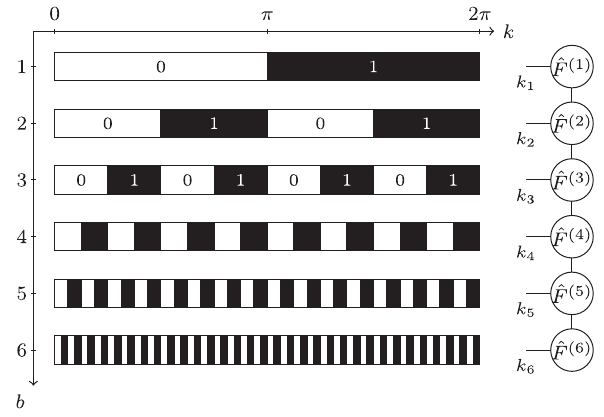
1. Multiscale ansatz for momentum space. Each row, numbered by the bond index b , corresponds to a different level of discretization of the 1D momentum k (different length scale). In this way, k can be represented by a set of bits k 1 ; … ; k (see text). R On the right, the QTT representation of a momentum-dependent FIG. 2. (a) QTT representation in momentum space. The function Eq. (2) is rightmost bits (indices) represent fine structures in momentum space. Low entanglement structures are assumed between differ- ent length scales. (b) Schematic illustration of the bond dimen- sions along the chain representing the momentum dependence. The dashed line indicates the maximum bond dimensions in maximally entangled cases. (c) Fourier transform from momen- tum space to real space by applying a MPO. The orange diamonds represent the MPO tensors. The structure of the MPO is illustrated in Fig. 27 in Appendix